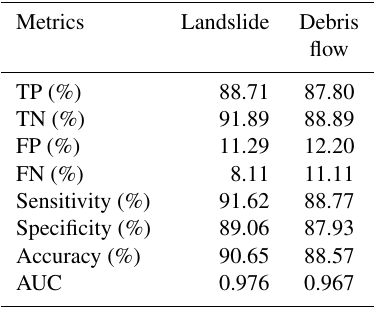
Table 1. Models’ performance using the training dataset.